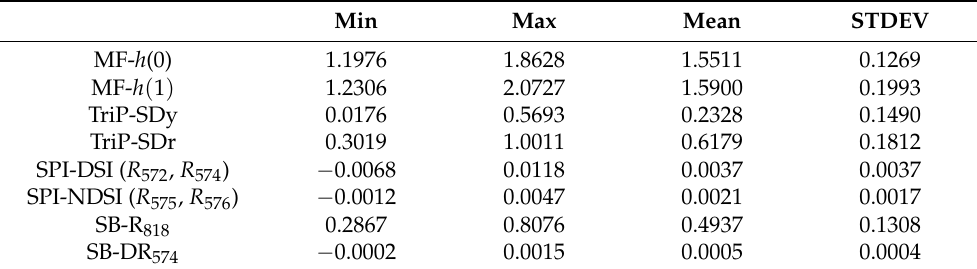
Table 4. The statistics of the eight selected spectral